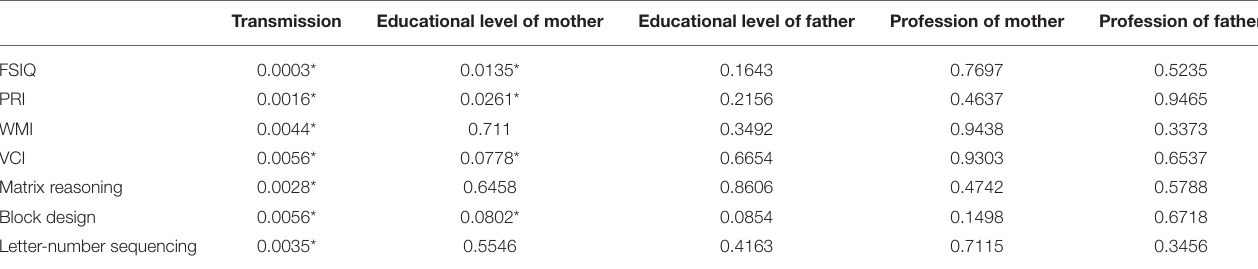
TABLE 3 | p -values for individuals effects (NF1 group, level of education mother and father, profession mother and father) from a 5-factor ANOVA performed on each significant numerical